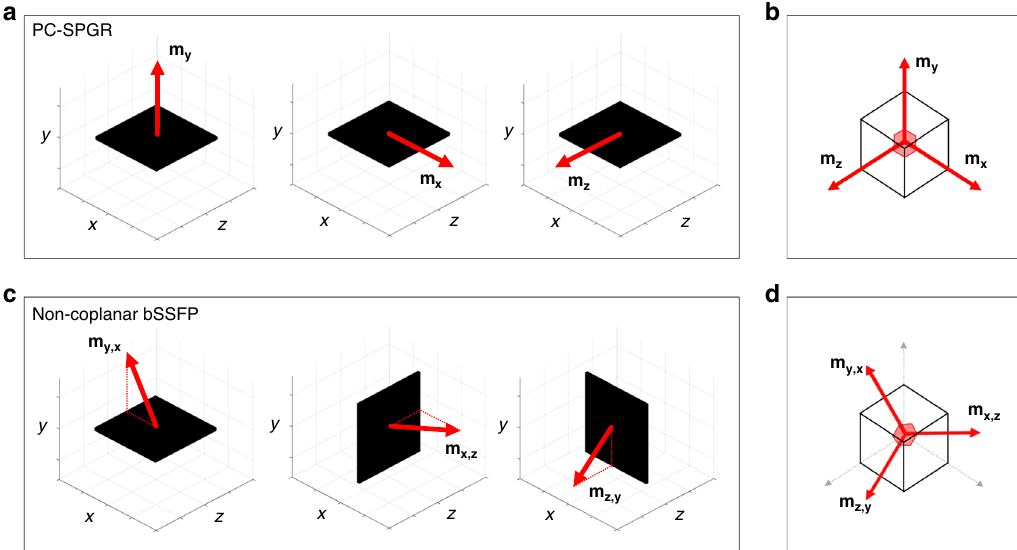
Fig. 7 Velocity encoding using a standard paradigm versus a non-coplanar multi-stack approach compatible with slice-to-volume registration (SVR). a In standard velocity-encoding, such as using a spoiled gradient echo (SPGR) sequence, the imaging slice (black) is held fi xed and additional dedicated velocity sensitizing gradients are added to create fi rst moments ( m ) in speci fi ed spatial directions ( m x , m y , m z , where subscripts denote the spatial directions of the velocity encoding). Note that there are also typically fi rst order moments associated with the native imaging gradients, which add a constant additional encoding, but this is not shown as it is usually subtracted out. b For each imaged voxel, the three velocity-encoding directions are orthogonal and conventionally aligned with the imaging axes. c Volumetric reconstruction using SVR requires the acquisition of non-coplanar stacks. In this case, the directionality of the fi rst moment associated with the intrinsic imaging gradients is maintained relative to each acquired slice and this provides three-directional velocity-encoding. Slice selective imaging sequences generally have intrinsic velocity-sensitivity that is oblique to the slice plane. In the case of the bSSFP sequences deployed in this study senitization is along the slice and read directions (hence m y,x , m x,z , m z,y in the fi gure). Combining three non-coplanar stacks of slices ( d ) provides data at the location of each voxel with three non-colinear velocity sensitizations, now oblique to the imaging axes. (Note that in this fi gure the coordinate axes show spatial directions. The arrows indicate only the directions in space of the relevant gradient